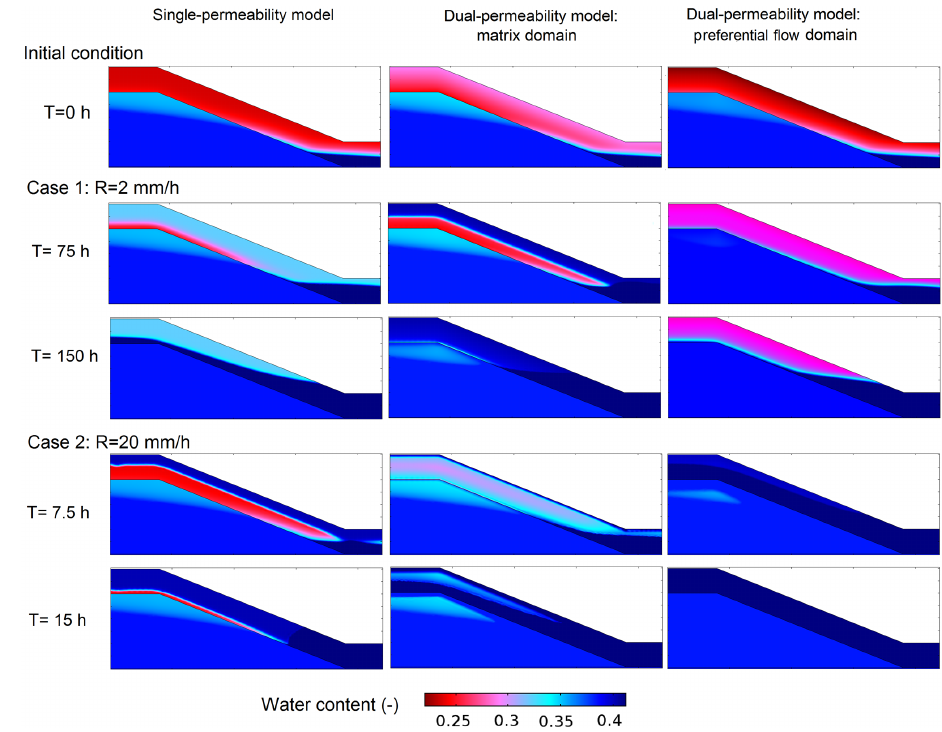
Figure 7. Water content